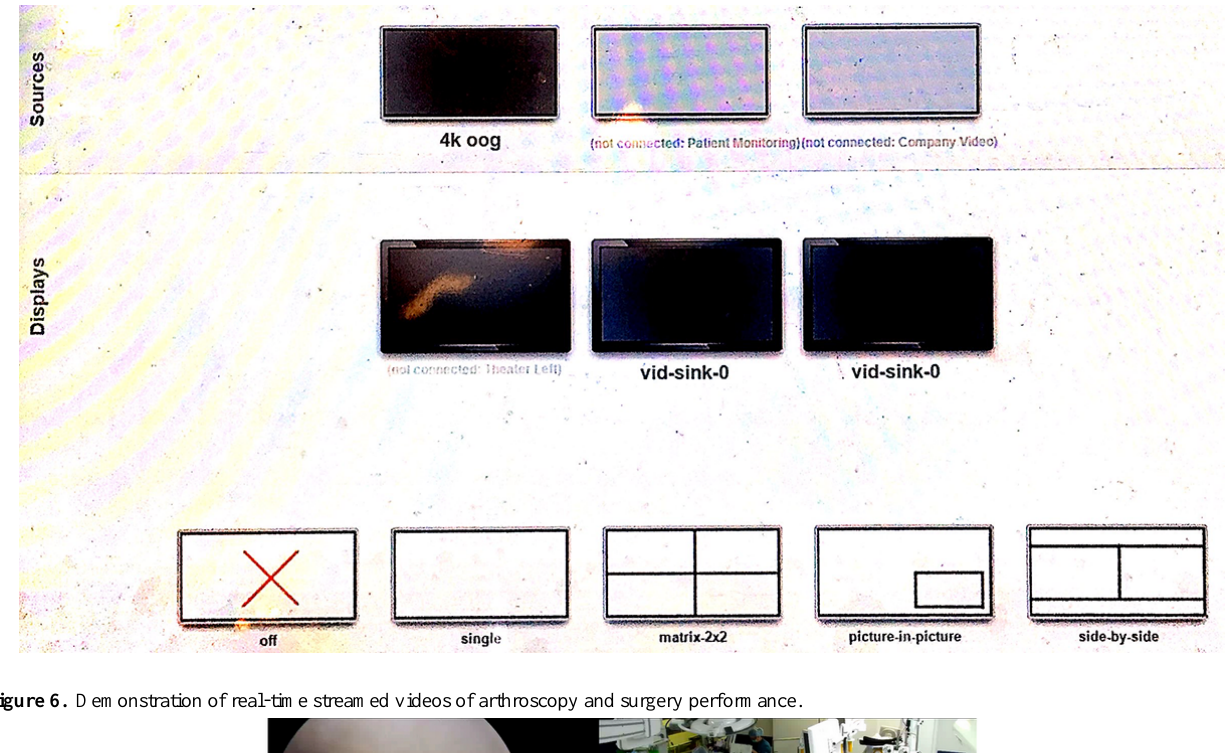
Figure 5. Screenshot of the wireless control panel (MIT-W101).